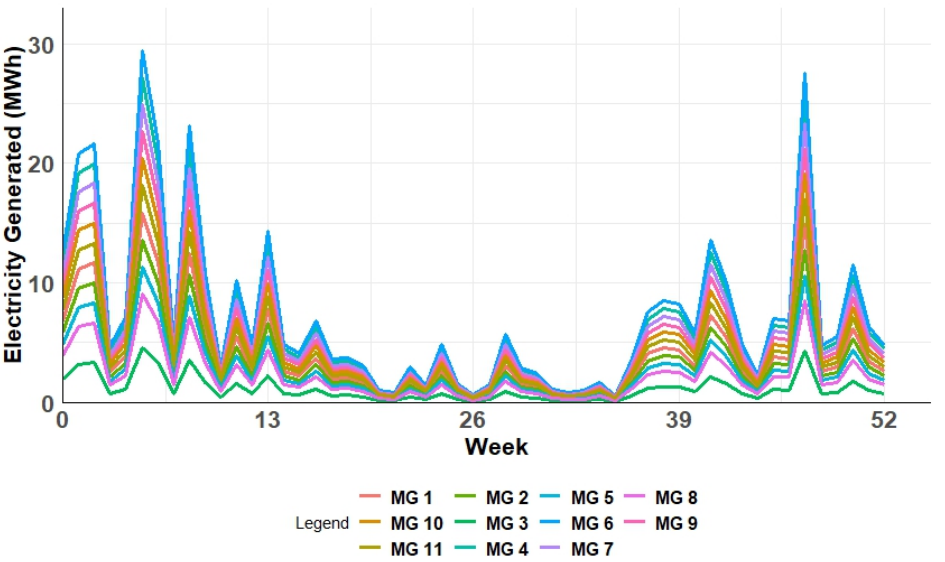
Figure 9. Weekly solar energy (MWh) generated at each microgrid over a one-year time period.